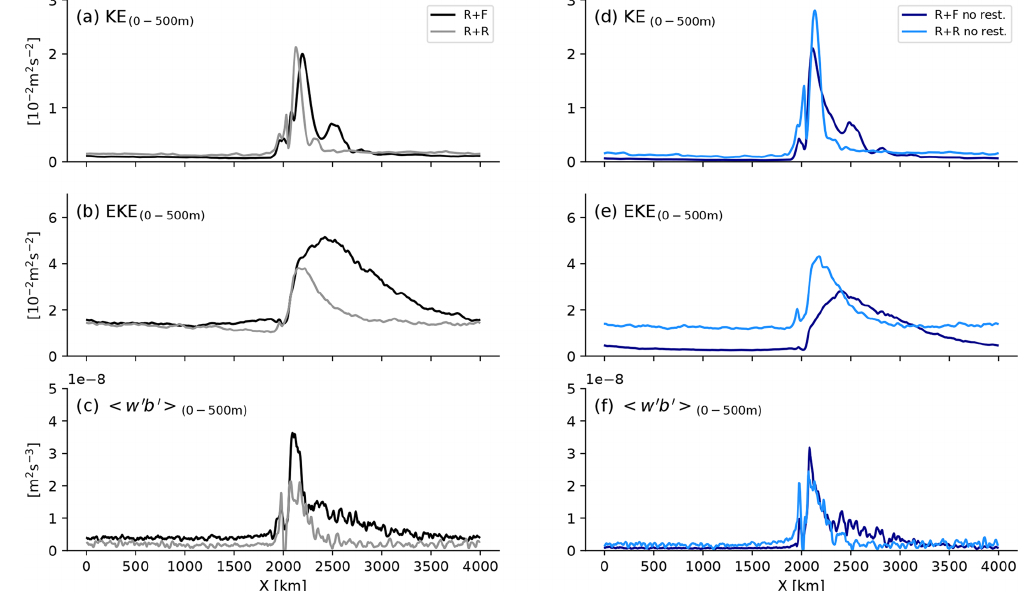
Figure 8. Zonal distribution of 10-year-averaged (a, d) mean kinetic energy (m 2 s − 2 ) , (b, e) eddy kinetic energy (m 2 s − 2 ) and (c, f) < w (cid:48) b (cid:48) > vertical eddy buoyancy flux (m 2 s − 3 ) . Quantities were averaged over the full domain in the meridional direction and between the surface and 500m depth. The velocity ( u (cid:48) , v (cid:48) , w (cid:48) ) and buoyancy ( b (cid:48) ) anomalies use to compute the eddy kinetic energy in (a) and the buoyancy flux in (c) and (f) are anomalies with respect to the 10-year temporal